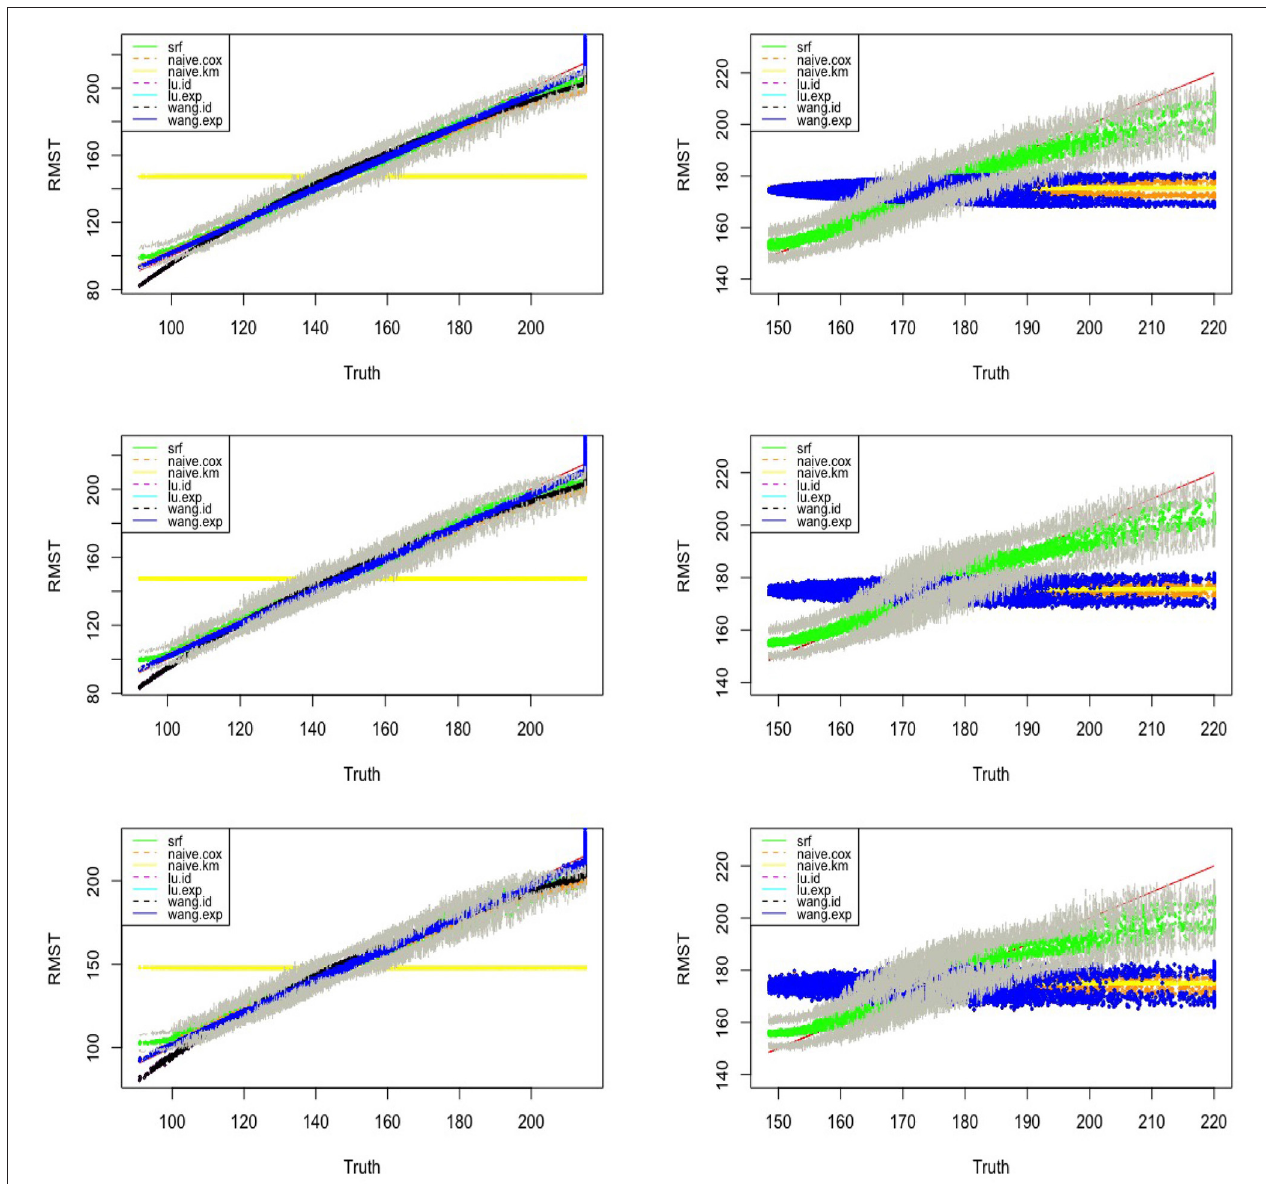
FIGURE 4 | Estimated vs. the true RMST for Model 1 (left) and Model 2 (right) with exponential link function and the number of covariates p = 5,10,20 (top–bottom) . SRF, proposed random forest-bases estimator, and upper and lower bounds of the point-wise confidence intervals of the proposed random forest estimator are connected in the gray lines; Naive.km, estimate based on Kaplan–Meier estimator without adjusting for the covariates; Naive.Cox, Cox regression based estimator; Lu.id, method of Tian et al. (2014) with identity link; Lu.exp, method of Tian et al. (2014) with exponential link; Wang.id, method of Wang and Schaubel (2018) with identity link; Wang:exp, method of Wang and Schaubel (2018) with exponential link.